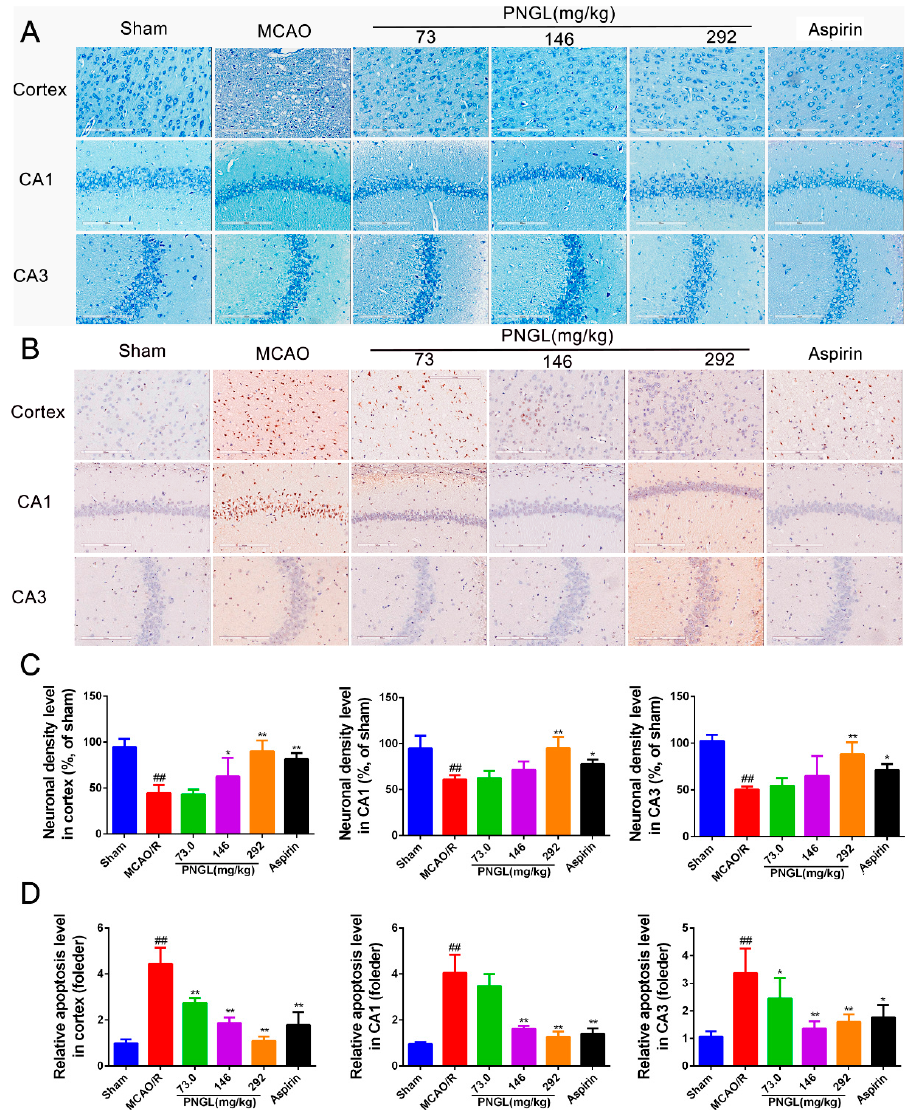
Figure 5. PNGL decreases neuronal apoptosis and neurons loss caused by ischemia. PNGL decreases neuronal apoptosis and neurons loss caused by ischemia in rats. ( A ) Representative images of Giemsa staining performed in hippocampus CA1, CA3 regions, and cortex regions from ischemic brains, measured by an in situ apoptosis detection kit. ( B ) Representative images of TUNEL assay performed in hippocampus CA1 and CA3 regions, and cortex regions. ( C ) The relative neuronal density (%, of sham) in the in hippocampus CA1 and CA3 regions, and cortex regions in all groups ( n = 4 in each group). ( D ) The relative neuronal apoptotic rate levels in the in hippocampus CA1 and CA3 regions, and cortex regions in all groups ( n = 3 in each group). Mean values ± SD; * p < 0.05, ** p < 0.01 versus MCAO / R group; ## p < 0.01, versus sham group. Scale bar, 200 µ